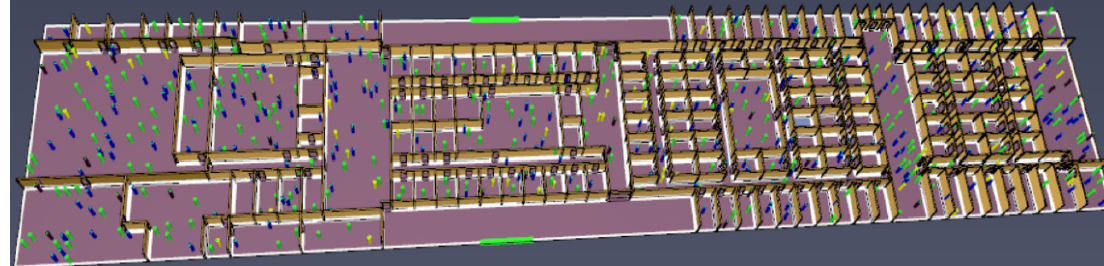
Figure 3. Ship Deck Evacuation 3D model.